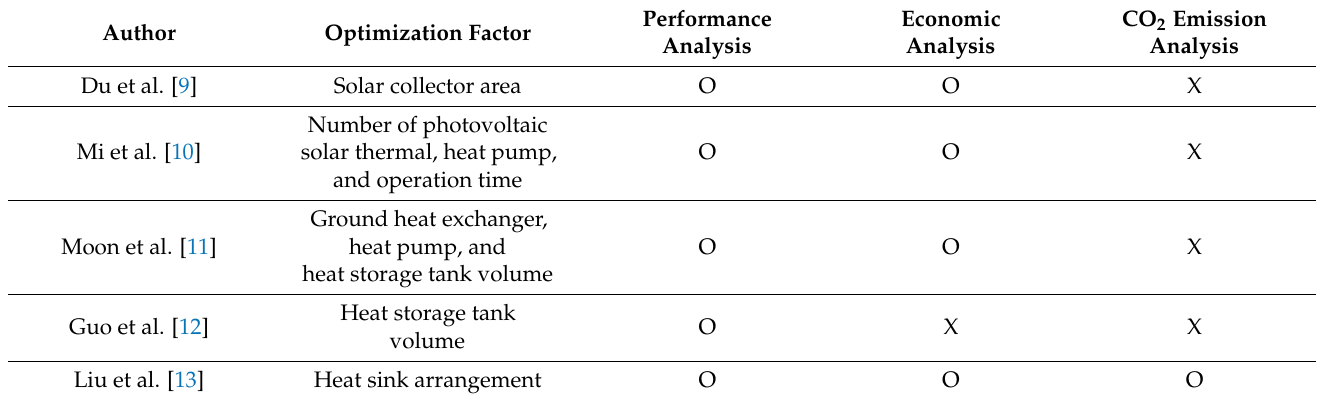
Table 1. Previous studies regarding optimization of energy